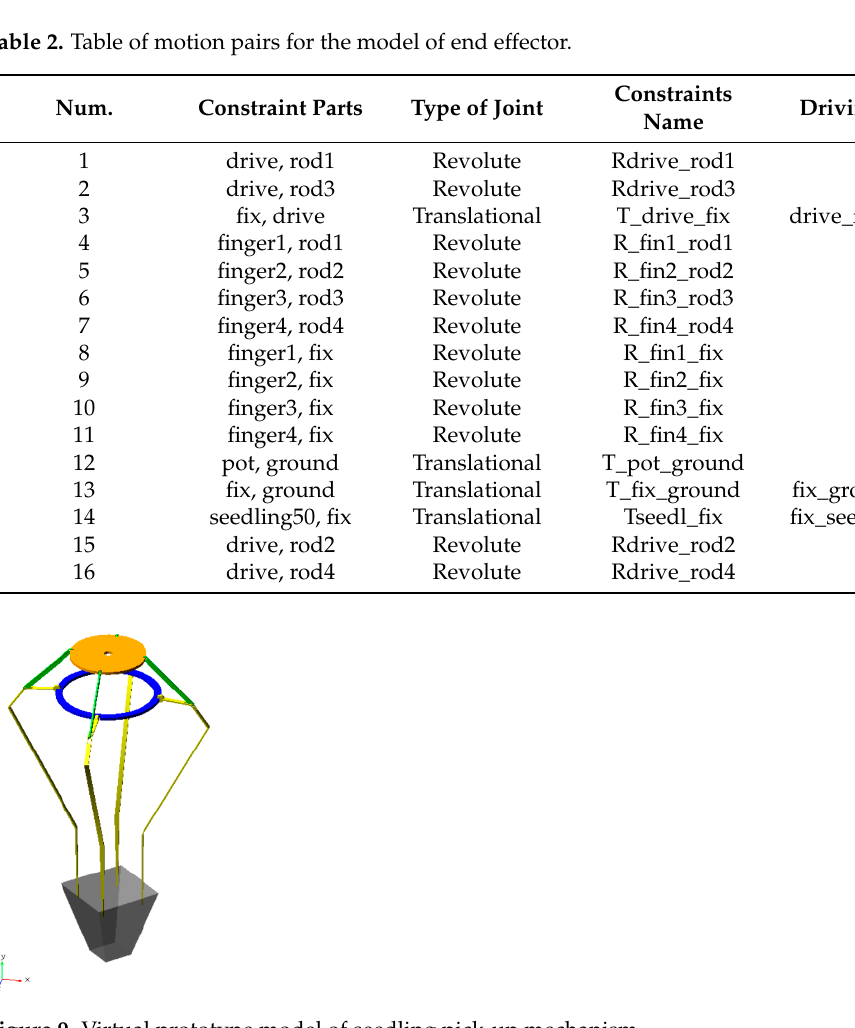
Table 2. Table of motion pairs for the model of end effector.